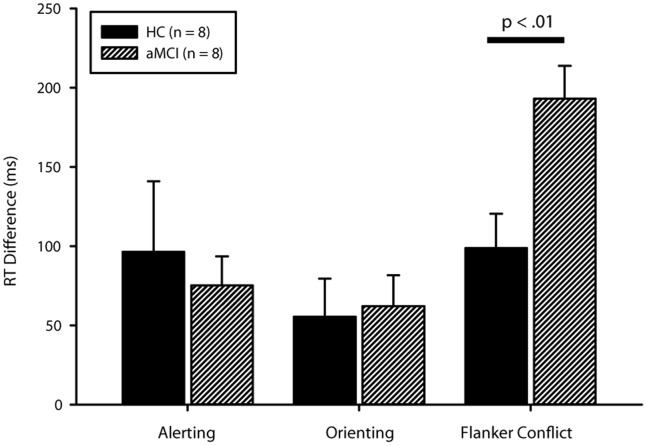
Group differences in median reaction time by attentional function.Only the group difference for the flanker conflict (executive control) effect reached significance at p<0.05 (actual p<0.01). Error bars represent standard error.